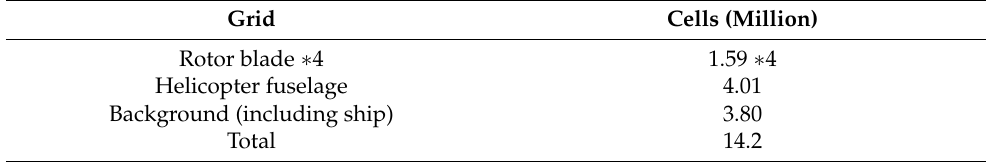
Table 3. The grid system used for the simulations of Combination 2.